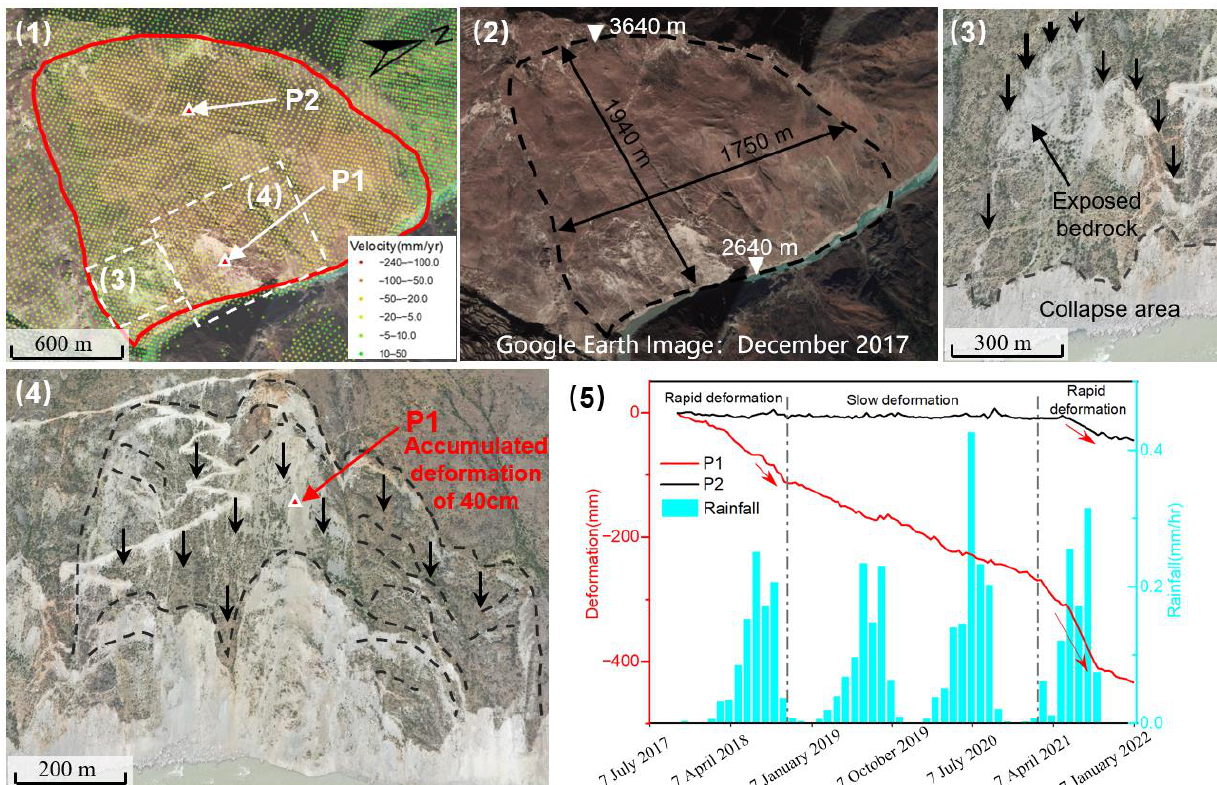
Figure 11. The Sela landslide in Gongjue County and its deformation characteristics: ( 1 ) average velocity of the landslide acquired from SBAS-InSAR; ( 2 ) Google Earth image; ( 3 ) local collapse at the toe of the landslide; ( 4 ) front part of the landslide has the largest deformation and has already begun to fail (black arrows indicate the direction of movement); ( 5 ) relationship between monthly precipitation and points P1 and P2 time-series deformation. The black arrows in the figures represent the direction of movement.